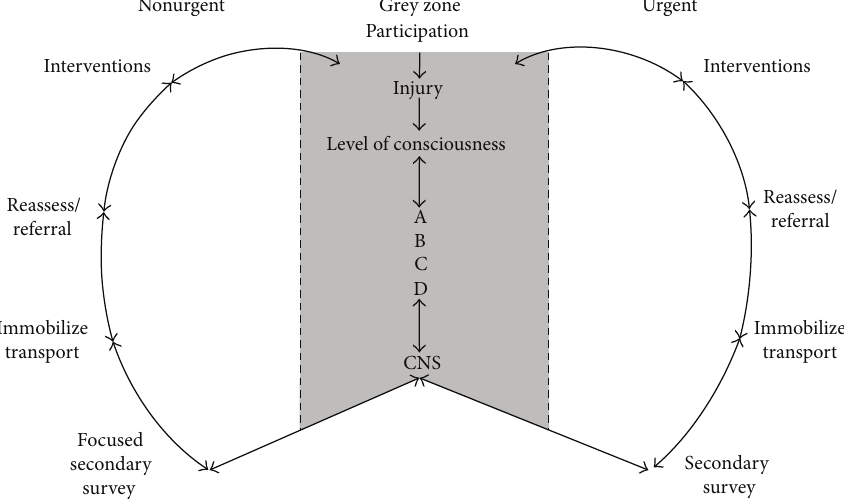
Figure 1: The Continuum of Care Conceptual Model for Athletic